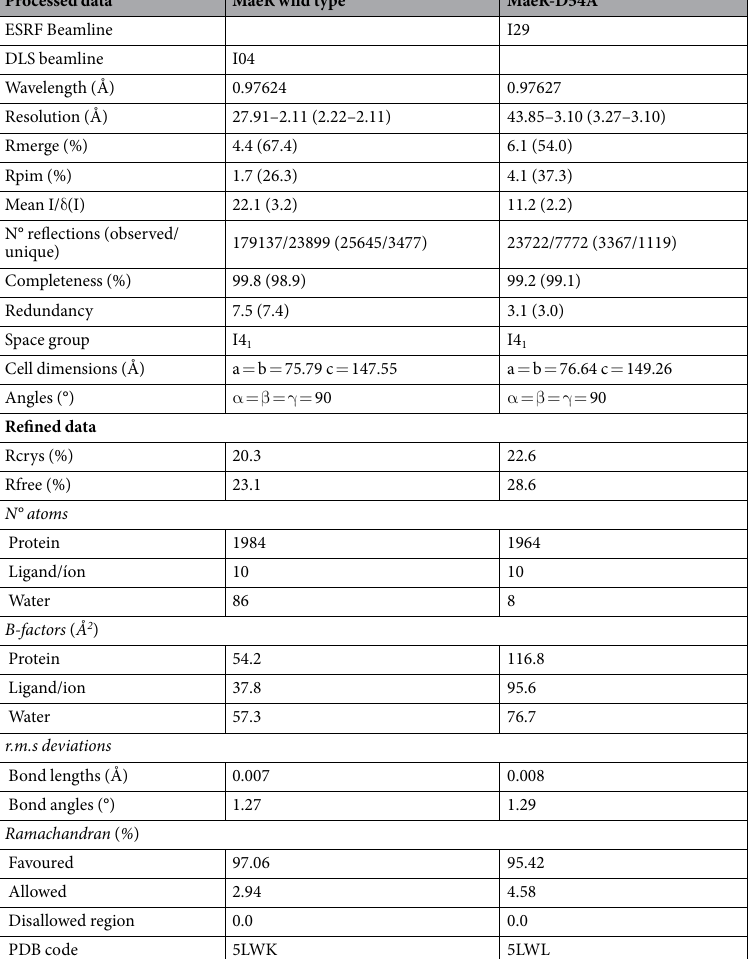
Table 1. Crystallographic data and refinement statistics of